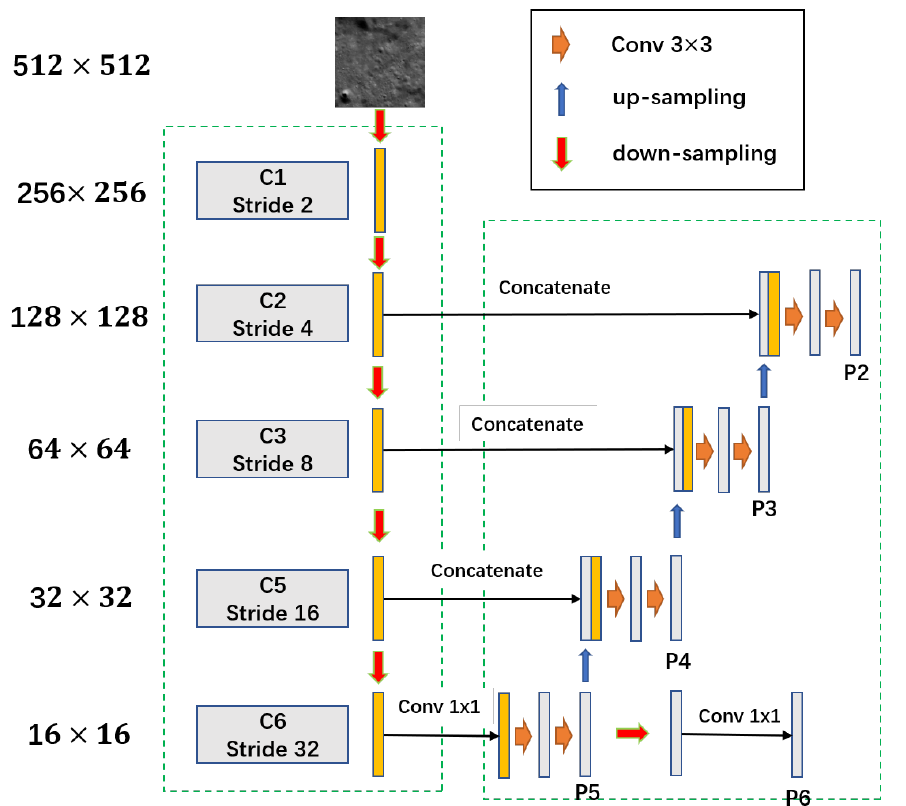
Figure 8. Improvements to encoding and decoding